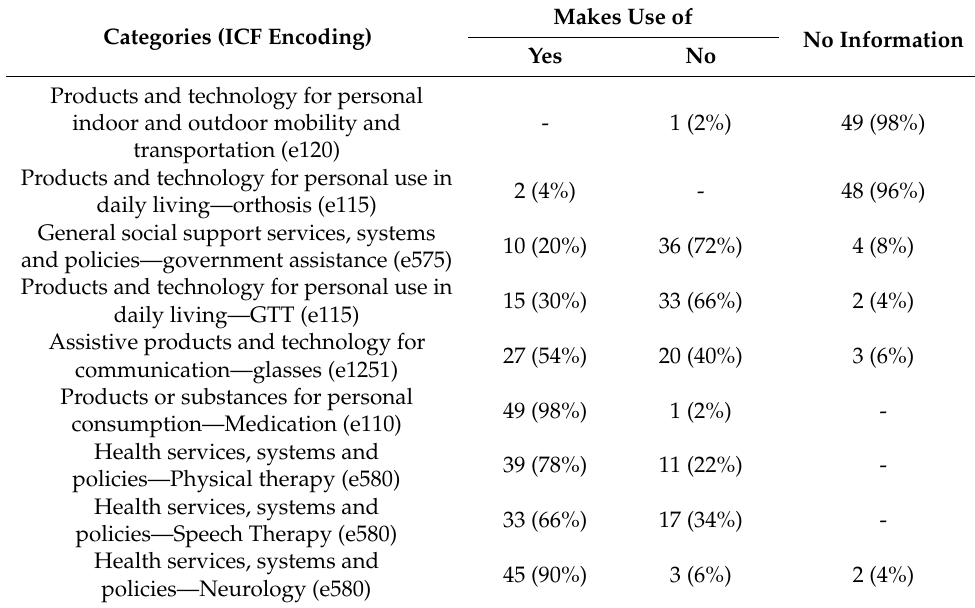
Table 4. Sample distribution according to environmental factors (n =